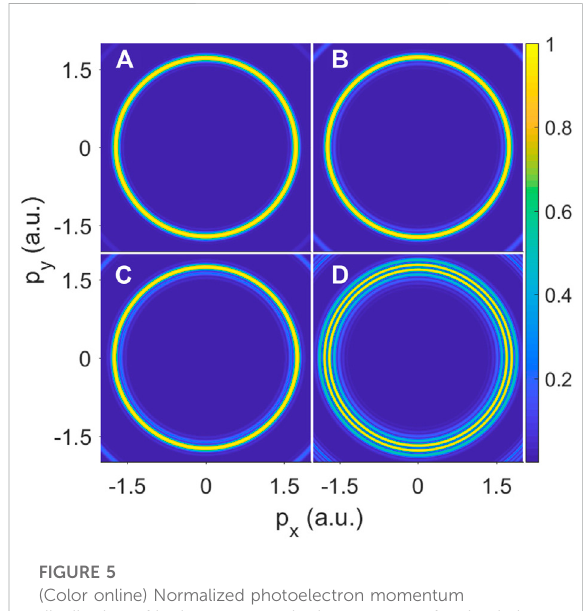
FIGURE 5 (Color online) Normalized photoelectron momentum distribution of hydrogen atoms in the presence of a circularly polarized laser pulse with different intensities: (A) 5 × 10 16 , (B) 5 × 10 17 , (C) 1 × 10 18 , and (D) 5 × 10 18 W/cm 2 . The other parameters are the same as those in Figure 3C.